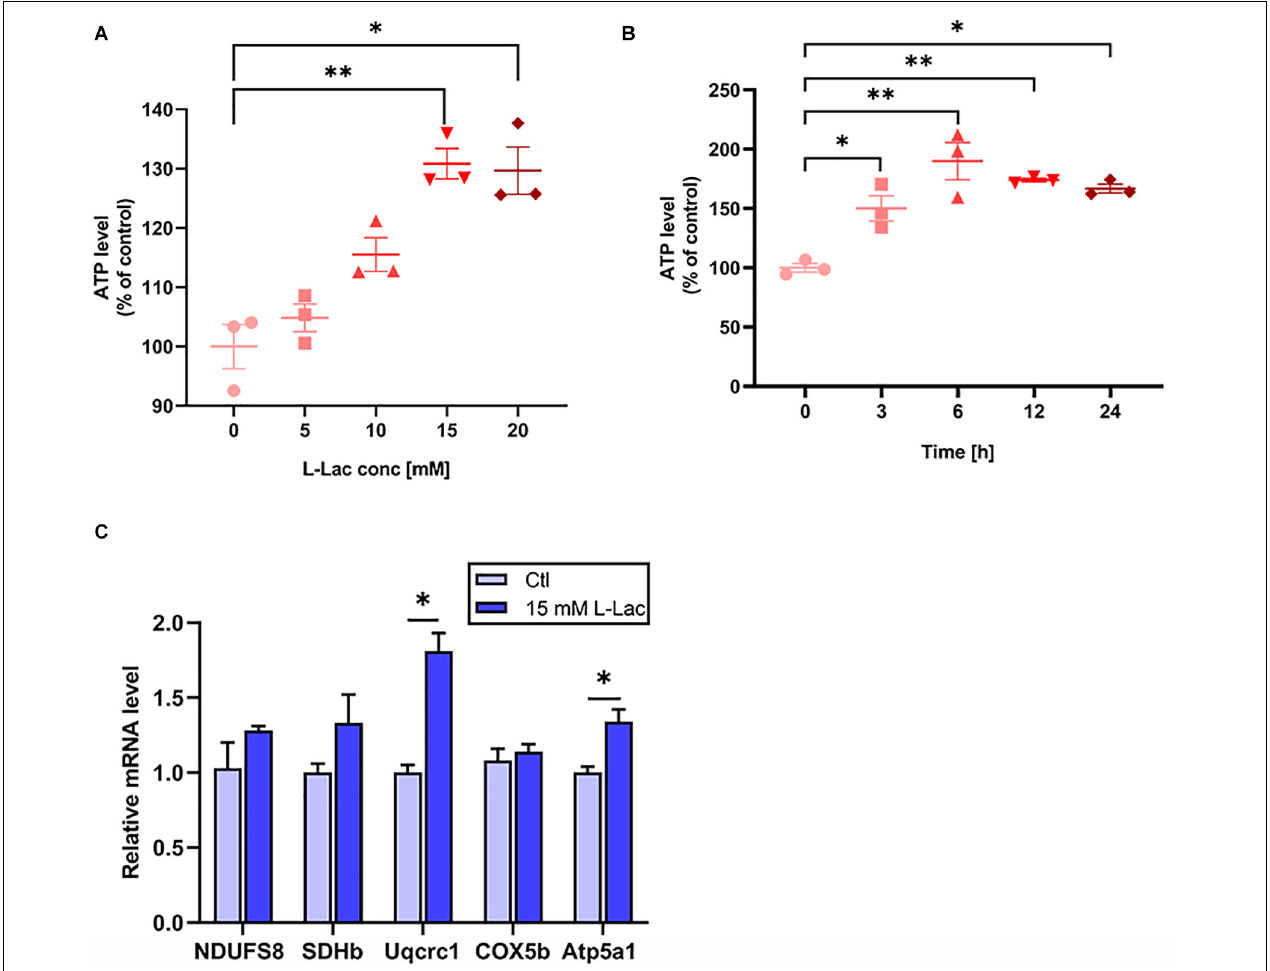
FIGURE 7 | Lactate increased the OXPHOS related genes expression and ATP levels in primary hippocampal cells. The mice primary cultured hippocampal cells were treated with different concentration of L-lactate (5, 10, 15, and 20 mM) for 24 h and different time points (3, 6, 12, and 24 h) following 15 mM lactate treatment for determination of the effect of lactate on the levels of ATP. The levels of ATP were detected by Luciferase. The oxidative phosphorylation (OXPHOS) related genes (NDUFS8, SDHb, Uqcrc1, COX5b, and Atp5a1) was detected in the condition of 15 mM L-lactate treatment for 3 h by RT-PCR in primary hippocampal cells. (A,B) The ATP levels. (C) OXPHOS mRNA levels. The gapdh as the loading control. N = 3 in three independent experiments. ∗ P ≤ 0.05 and ∗∗ P ≤ 0.01 as compared with the Ctl group by non-parametric tests. Values are expressed as mean ± standard error of the